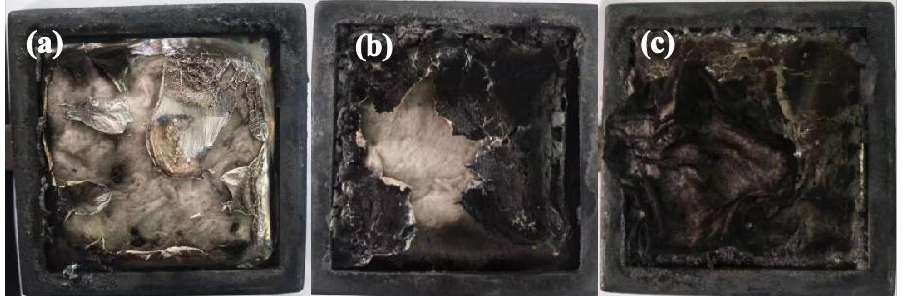
Figure 7. Digital photos of PLA/HABP-DOPO blends after cone calorimetry test: ( a ) pure PLA, ( b ) PLA/15%HABP-DOPO and ( c ) PLA/25%HABP-DOPO.